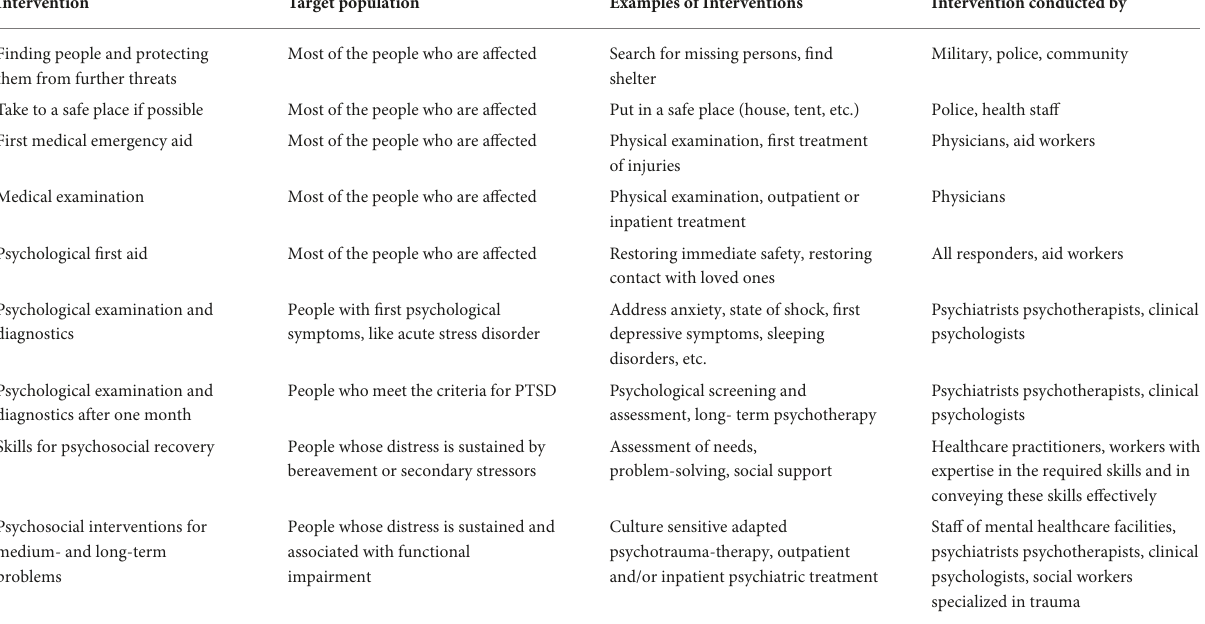
TABLE 1 Interventions after disasters [adapted from Kizilhan